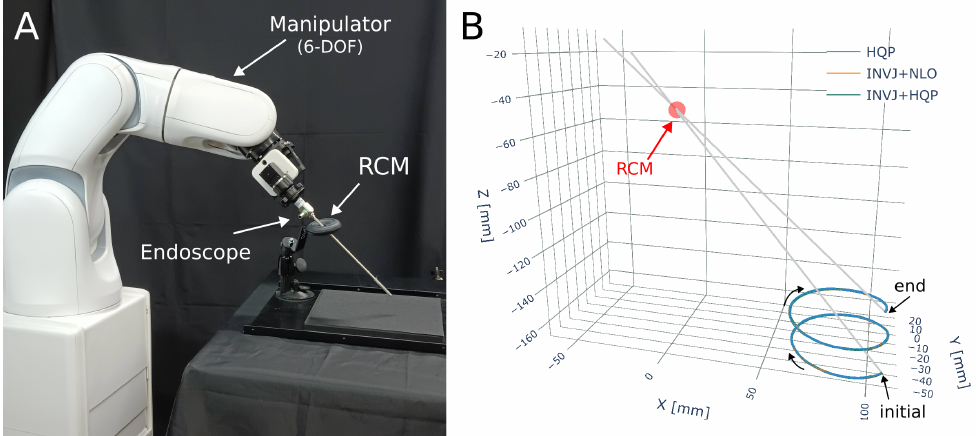
Figure 10. Endoscope positioning experiment ( A ) Experimental setup. A 6-DOF manipulator (VS 050, Denso Corp.) with a rigid endoscope mounted. ( B ) The RCM constraint and the helix trajectory followed for each IK solver.